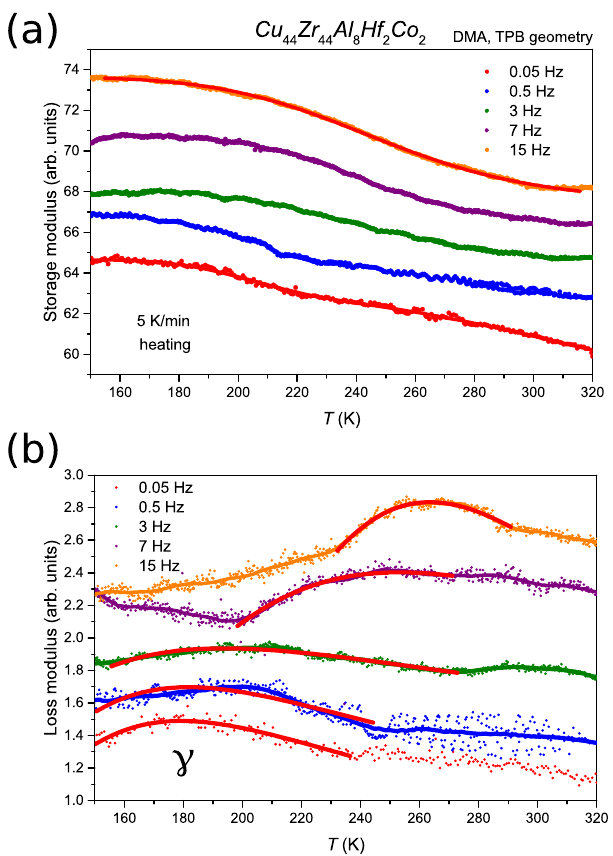
Fig. 6 DMA experiments probing the γ -relaxation. a Representing the storage modulus and ( b ) representing the loss modulus. Storage modulus curves for frequencies f = 0.05, 0.5, 7, and 15 Hz are shifted on the ordinate axis from the 3 Hz data for clarity. Cole – Cole fi ts of the data indicated in ( b ) by red lines are used for the determination of the activation